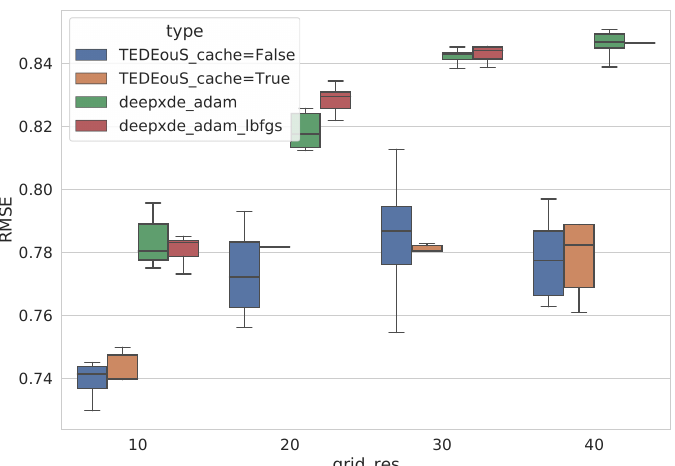
Figure 12. RMSE with respect to the analytical solution: orange—proposed approach without cache, blue—with cache, green—DeepXDE without additional LBFGS refinement, red—with LBFGS refinement.